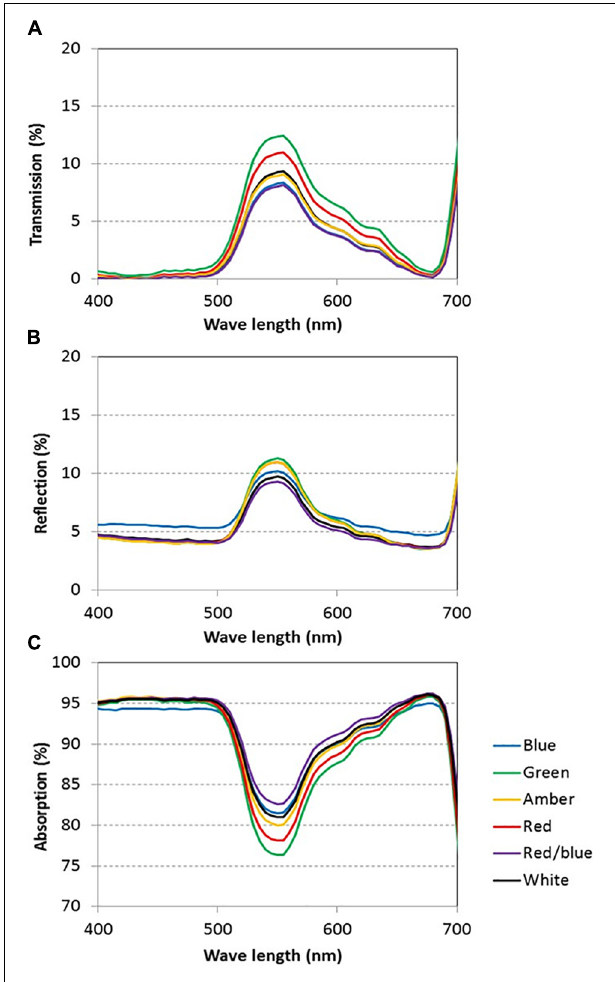
Spectral compositions are blue, green, amber, red, red/blue (95/5%) and white light, maintained during 21 days on contents of chlorophyll a, chlorophyll b, chlorophyll a:b ratio and carotenoids (n = 2, measured on 3 leaf disks of 4 plants). Different letters within columns indicate significant differences (P <